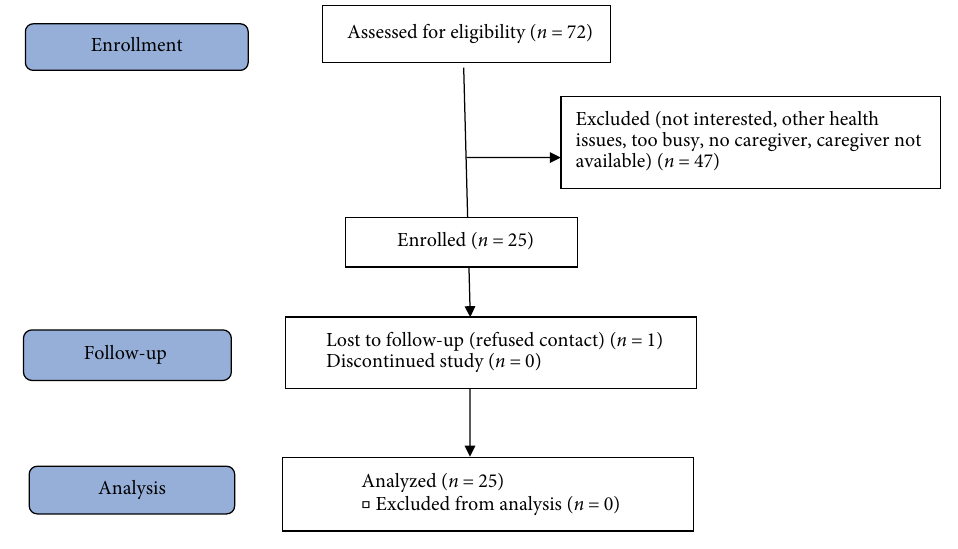
Figure 1: Sampling and flow of